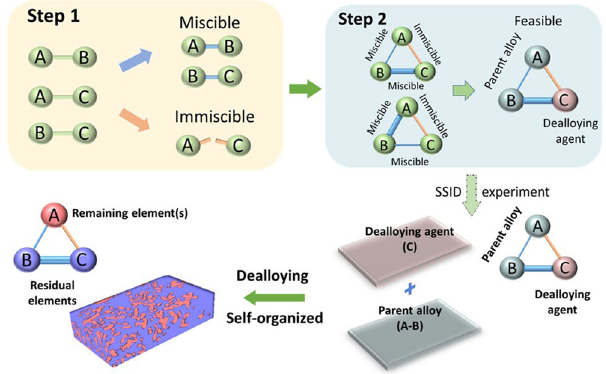
Fig. 2 Schematic of ML predictions of miscible/immiscible pairs and ternary dealloying systems. The two steps for predicting dealloying systems by the ML method. The fi rst step is to classify the miscible and immiscible pairs and compose potential ternary dealloying systems. The second step is to determine the parent alloy and the dealloying agent in each of the ternary systems that are prescreened in the fi rst